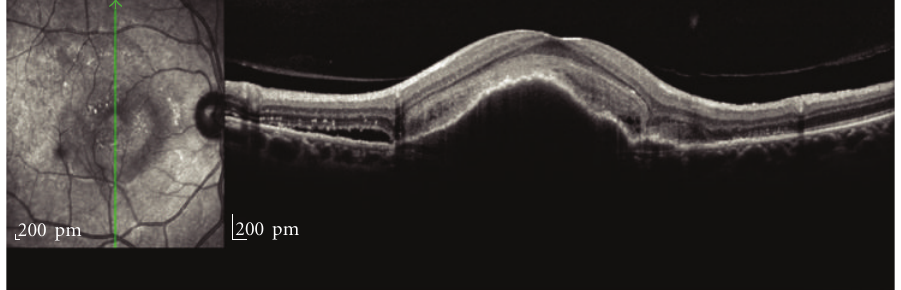
Figure 2: A 71-year-old man with a pigment epithelial detachment in the presence of neovascular AMD in the right eye. In the SDOCT scan the pigment epithelial detachment is readily visualized underneath the fovea associated with intraretinal cysts and subretinal fluid. It is also possible to identify the subretinal neovascular membrane and the vitreoretinal